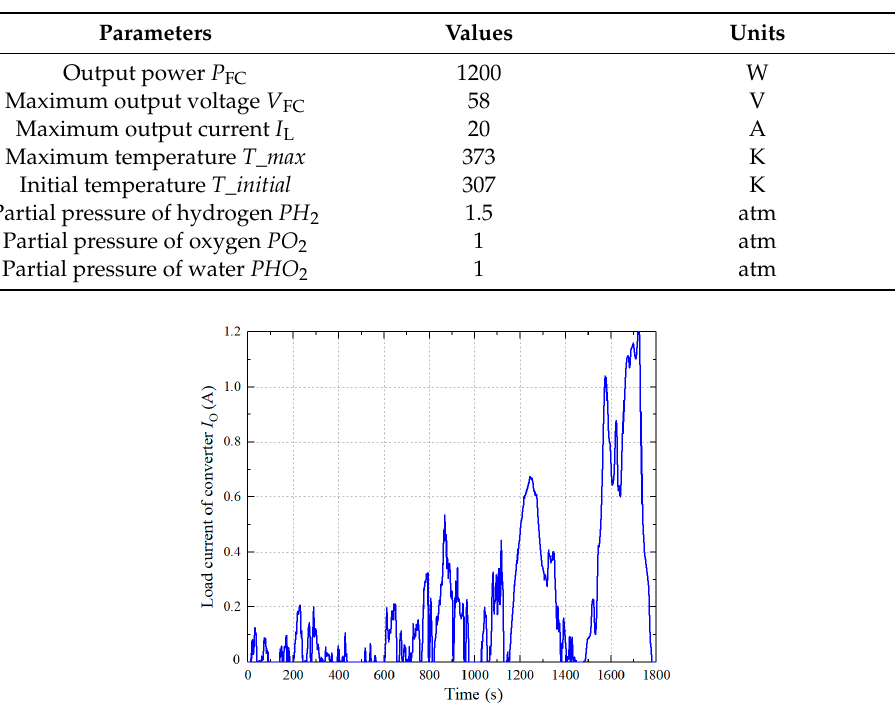
Figure 11. The output voltage of a fuel cell under the WLTP. The converter output voltage is shown in Figure 12. In order to maintain a stable output voltage of the converter, when the fuel cell output voltage drops, the duty cycle needs to be raised correspondingly. The duty cycle variation curve is shown in Figure 13.